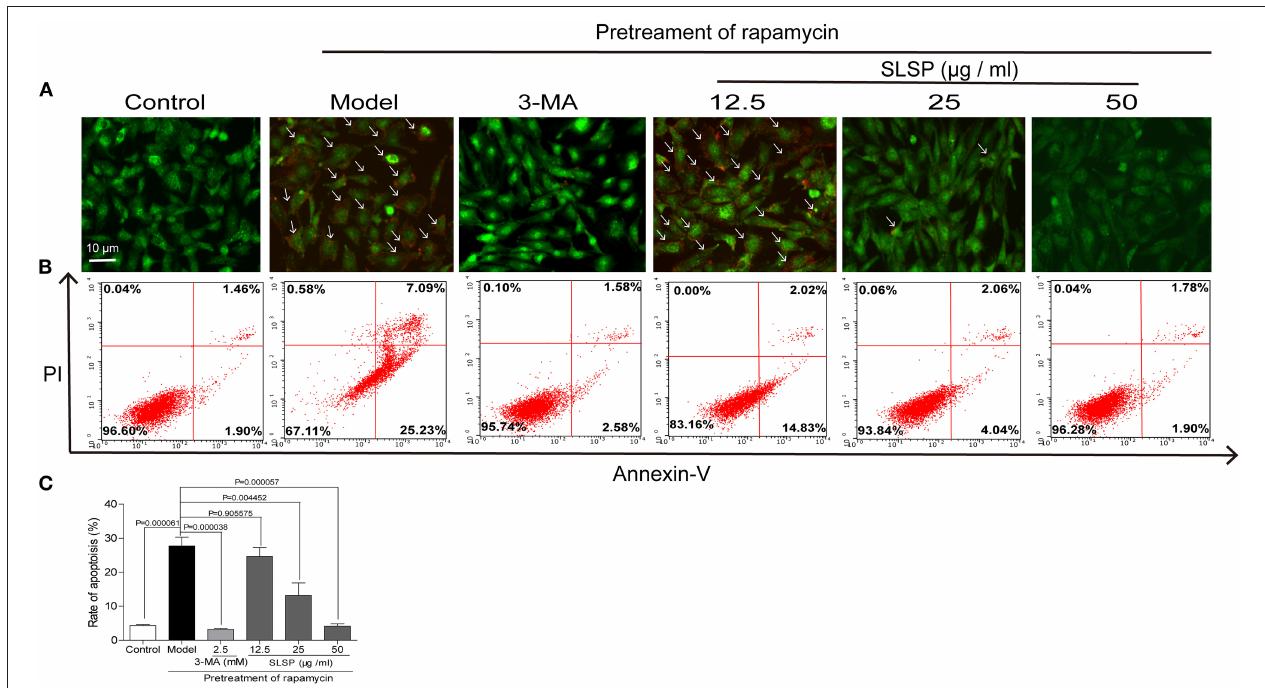
FIGURE 6 | SLSP inhibited the autophagy and early apoptosis of H9c2 cells. (A) SLSP reduced acidic vesicular organelles in H9c2 cells pretreated with rapamycin according to acridine orange (AO) staining. Arrows were added to mark the cells with acidic vesicular organelles. (B) SLSP decreased the percentage of apoptotic H9c2 cells pretreated with rapamycin through AnnexinV/PI staining. H9c2 cells were incubated with different concentrations (12.5, 25, and 50 µ g/ml) of SLSP for 48h after being pretreated with rapamycin (50 µ g/ml) for 4h and then subjected to annexin V and propidium iodide (PI) staining. (C) Rate of apoptosis. N = 3/group.